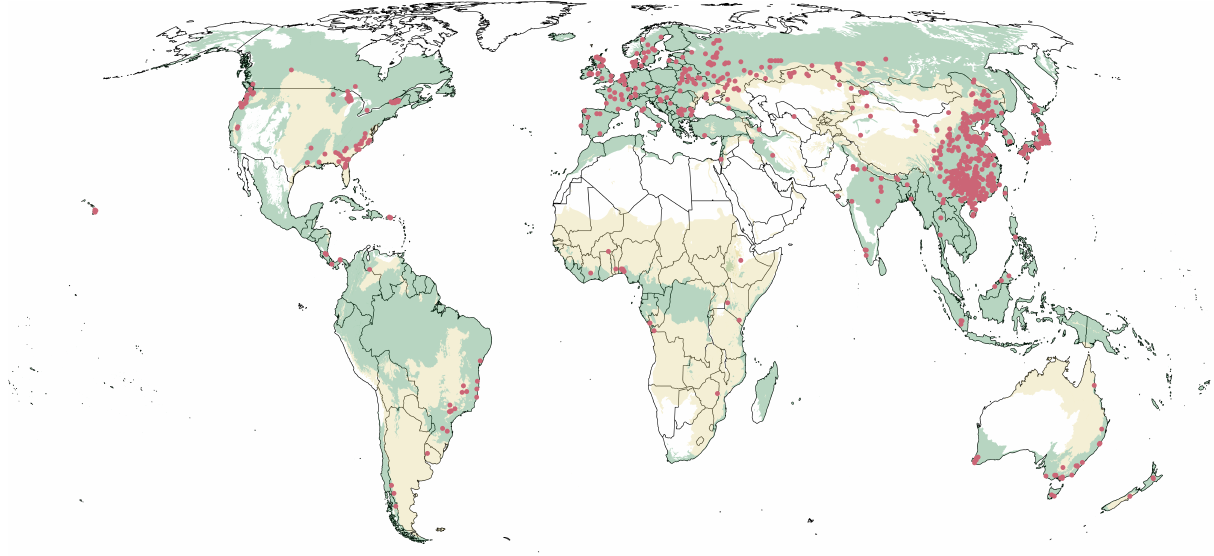
Fig. 1 Distribution of sites within the database. We identi fi ed a total of 4756 observations of aboveground biomass in plantations, spread across 829 sites. Forested biomes are displayed in light green whereas grassland, savannas, and shrubland biomes are displayed in pale yellow. We distinguish forested and savanna biomes separately since trees in savannas can have strongly negative